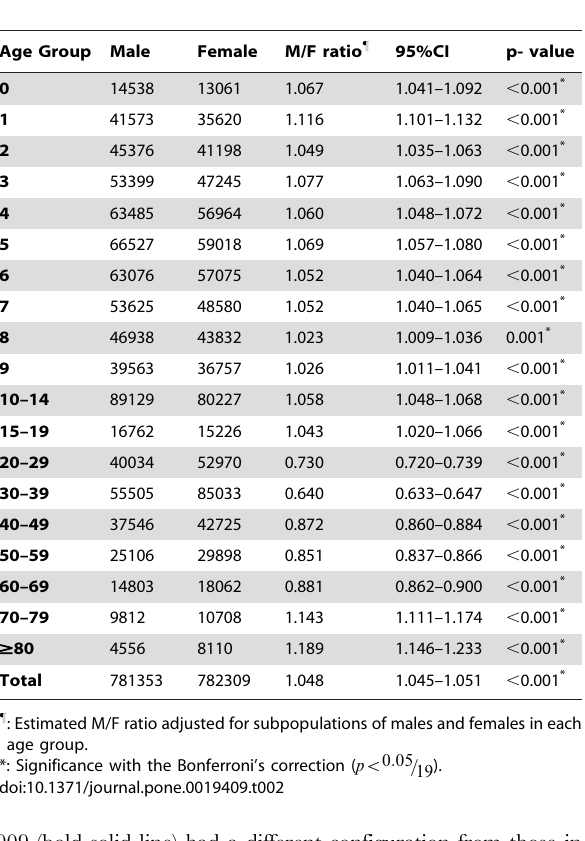
Table 2. The M/F ratio and number of patients with seasonal influenza, reported from fixed sentinel points in 2005.